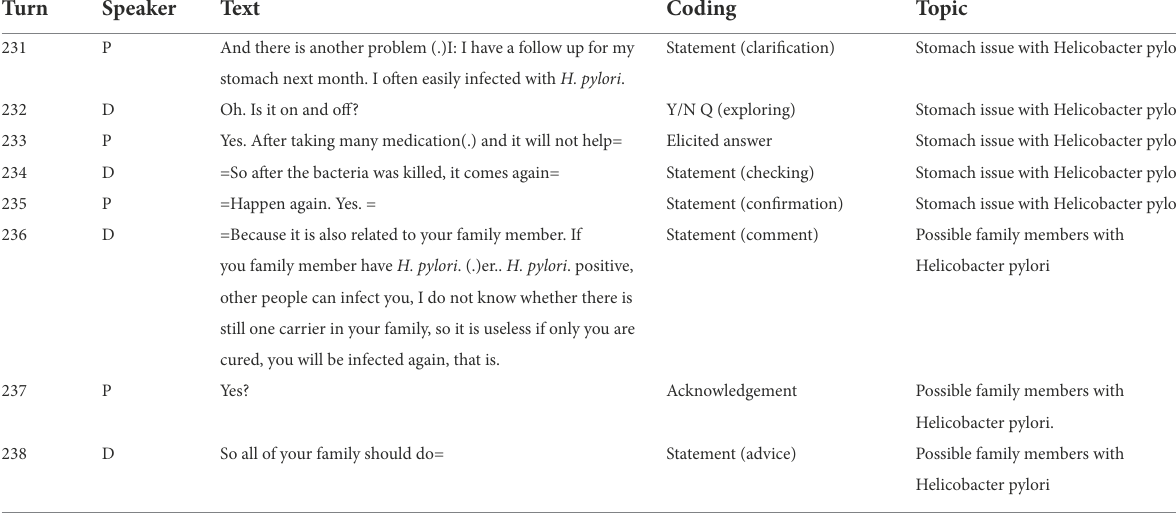
TABLE 4 Second example of communicating uncertainty to achieve consensus: past problems and future suggestions.